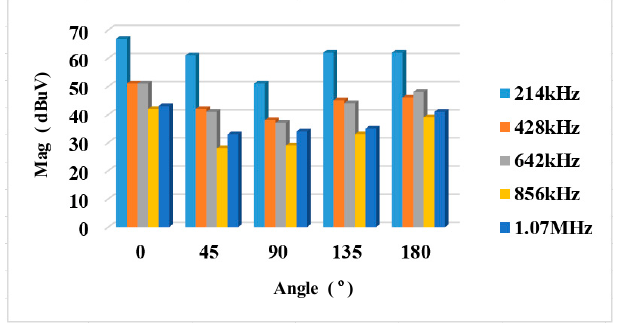
Figure 10. Measured CM conducted emission at different inductor placement angles.